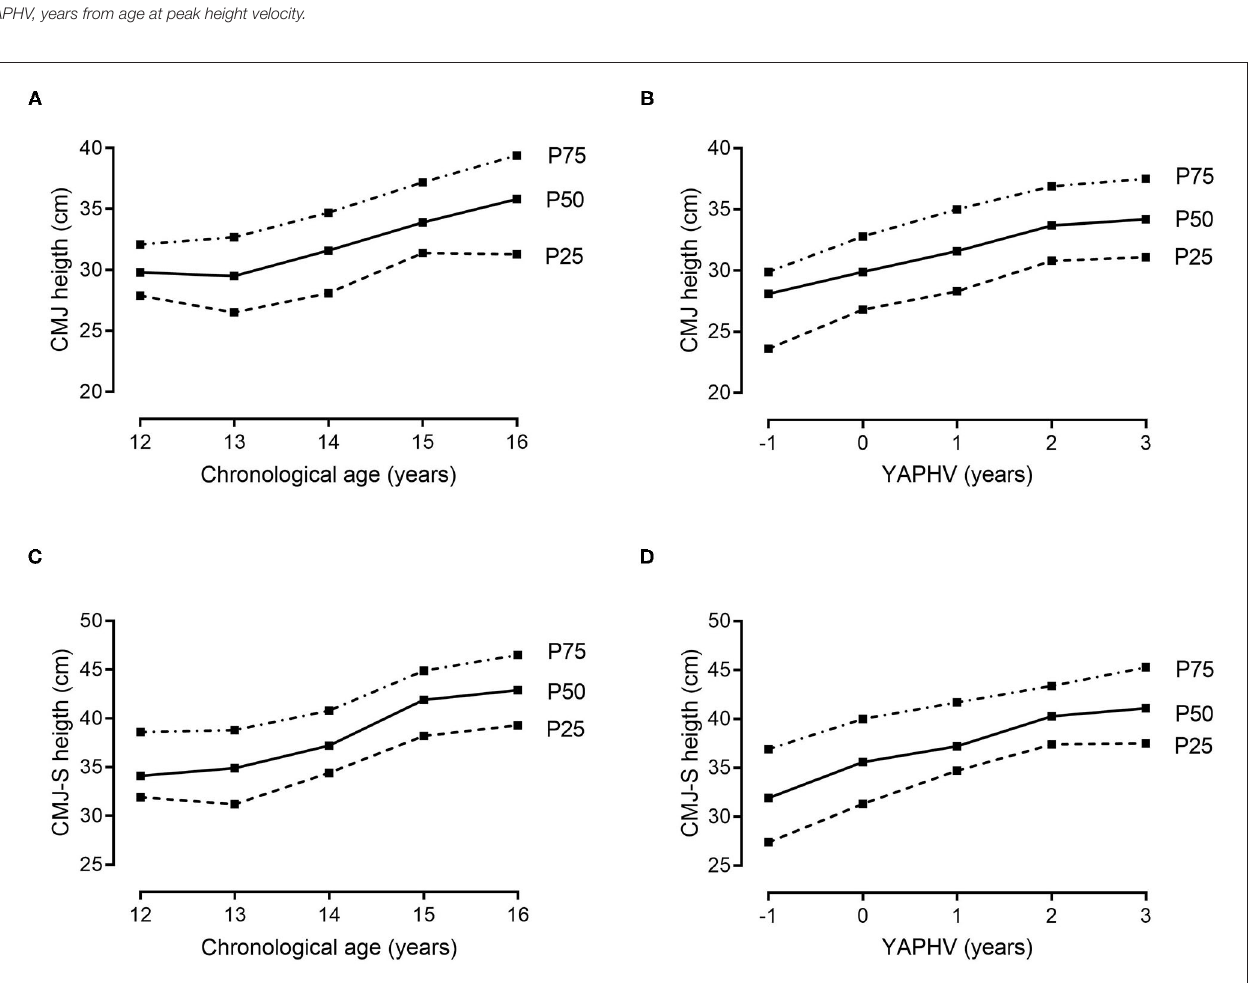
years ahead of PHV when compared to the players selected for the U-16 Portuguese National Team training camp (Arede et al., 2019), which could have influenced the results. Several studies